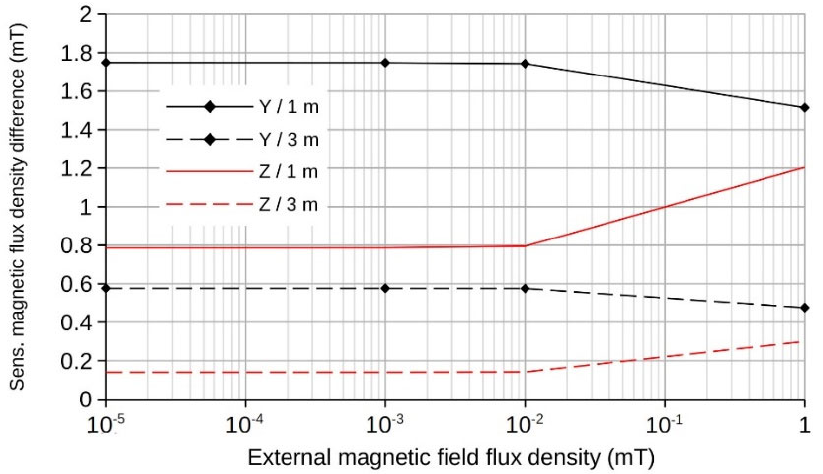
Figure 6. The dependence of the difference between the values of the Y- and Z-components of the magnetic field vector in the ferroprobe core between the current strength in the cable of 50 A and 600 A on the magnetic flux density value of the external field (for a distance of 1 and 3 m between the microtunneling shield and the cable axis).